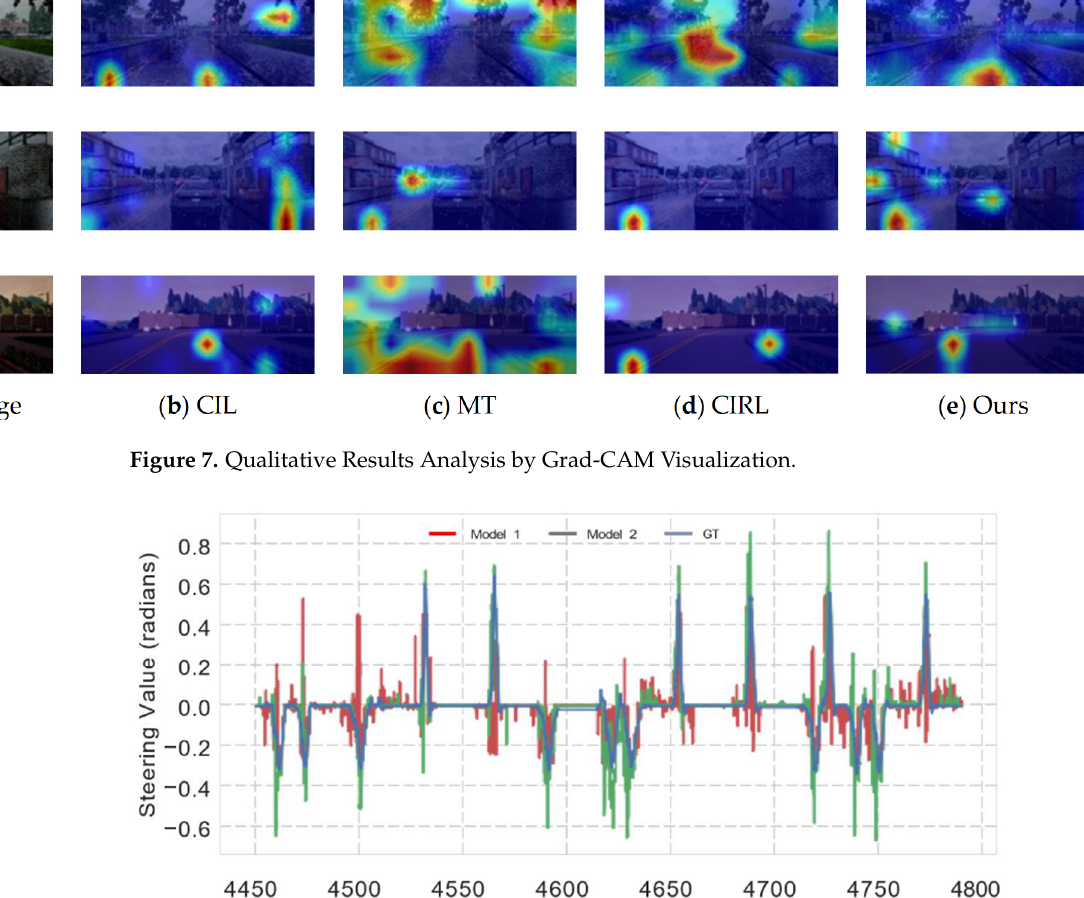
Figure 8. Detailed evaluation of two driving models with the prediction of steering wheel angle.